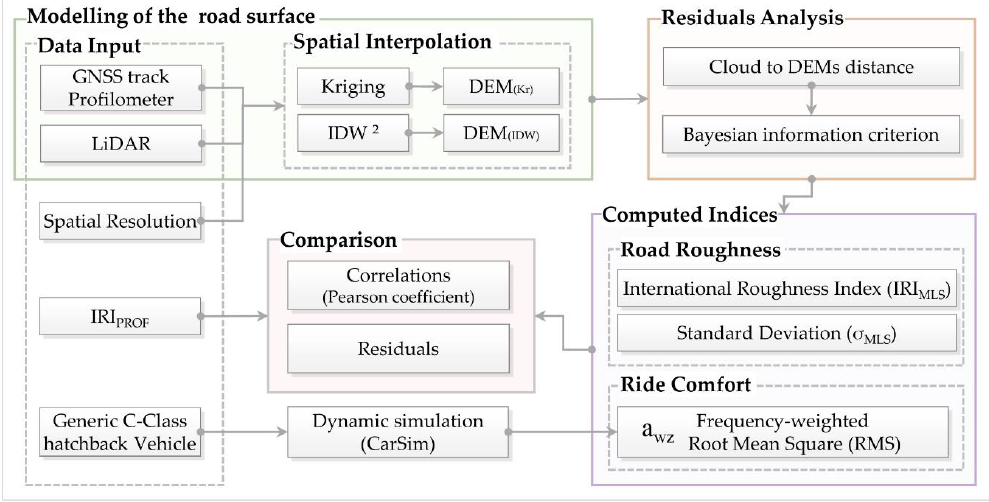
Figure 2. Workflow of data elaboration.